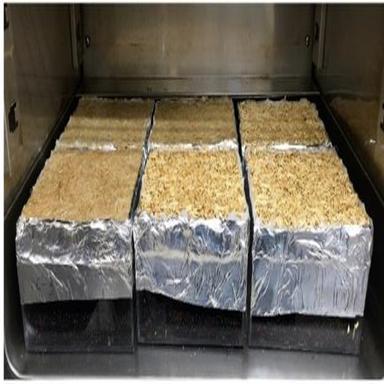
Test assembly of hemp composites for vapour permeability testing.